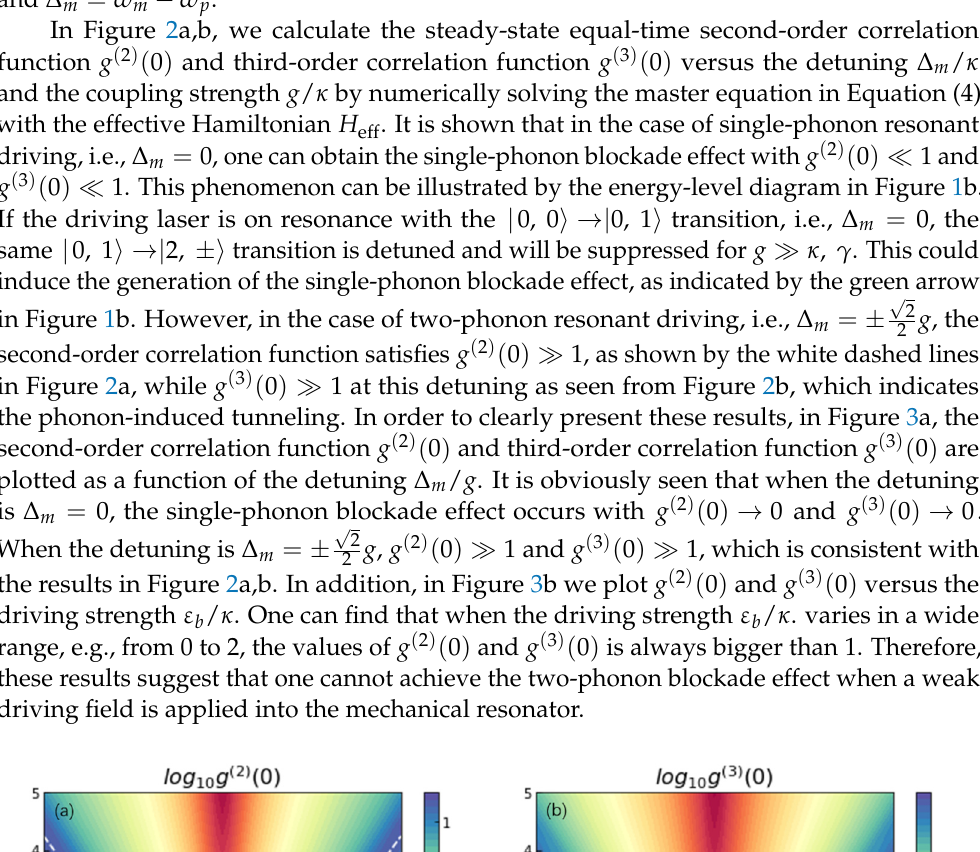
Figure 3. Steady-state equal-time second-order correlation function 𝑔 ((cid:2870)) (0) and third-order corre- lation function 𝑔 ((cid:2871)) (0) versus ( a ) the detuning Δ (cid:3040) /𝑔 and ( b ) the driving strength ε (cid:3029) /𝜅 when the